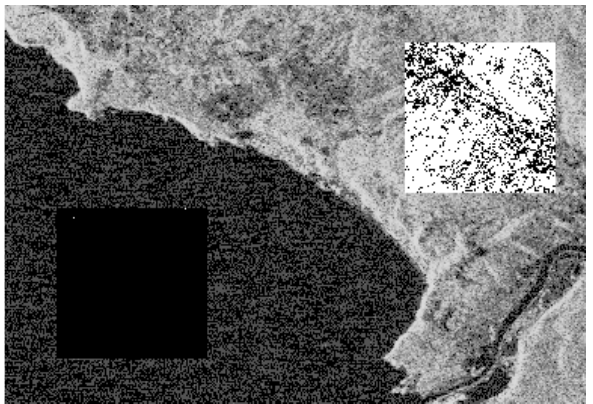
Figure 4. Defining threshold value for land and sea part of the images using 100x 100 search window.